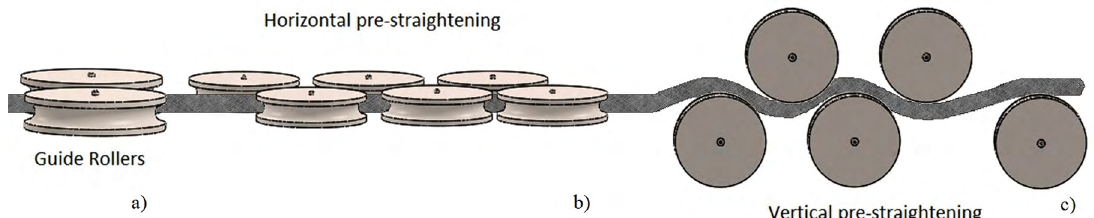
Figure 2. (a) wire rod (b) Horizontal and (c) vertical pre-straightening